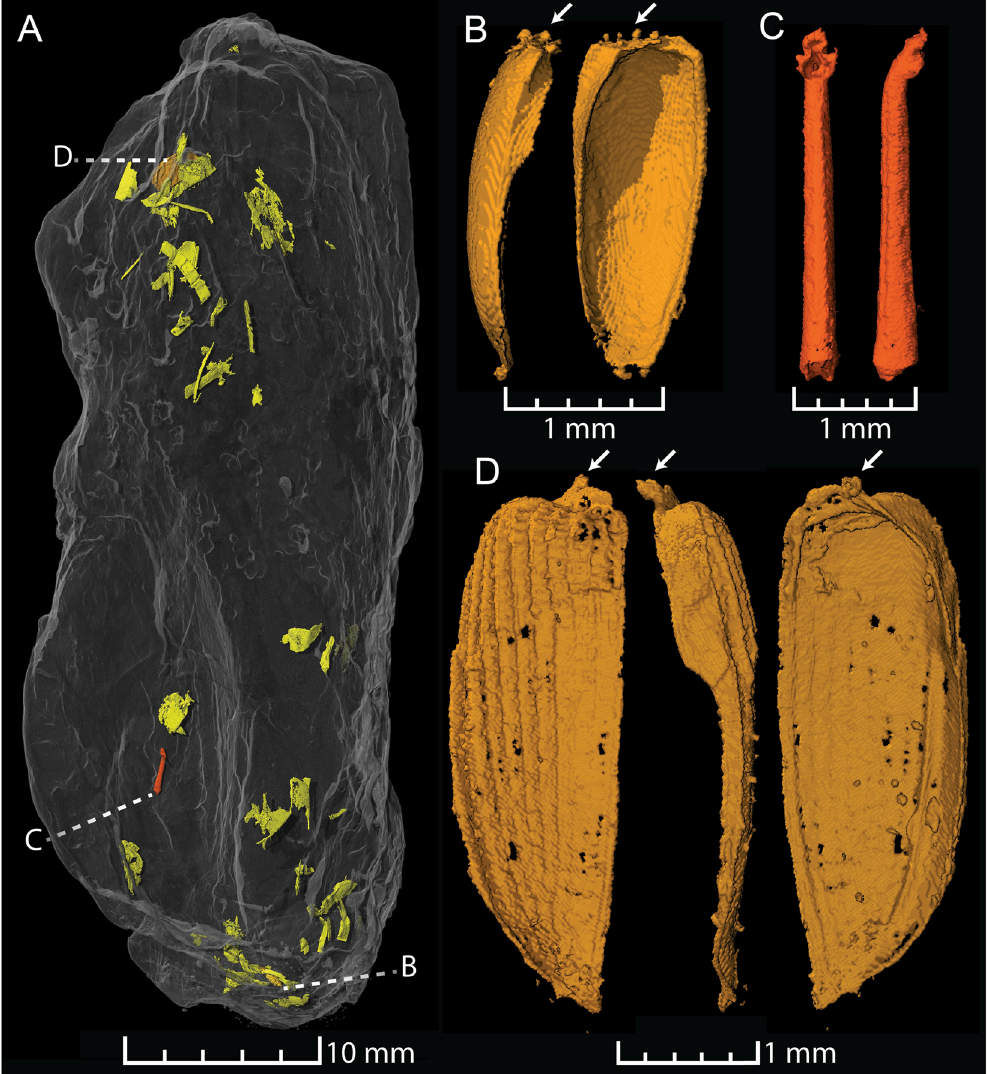
Figure 2. Insect inclusions in coprolite ZPAL AbIII/3402. ( A ) The entire coprolite (semi-transparent) and small fossil insect/arthropod inclusions colored in: brick red – insect tibia; gold – beetle elytra; greenish yellow – other arthropod inclusions. ( B ) Ventral and lateral views of a small beetle elytron. ( C ) Ventral and lateral views of an insect tibia, probably belonging to a beetle. ( D ) Beetle elytron (probably belonging to a beetle of the Polyphaga suborder) in dorsal (left), lateral (middle) and ventral (right) views. The white arrows indicate the articulatory roots of the